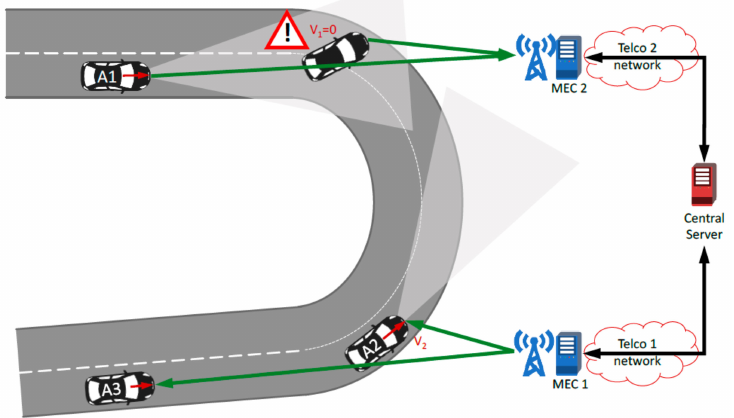
Figure 3. Typical scenario of the anticipated cooperative collision avoidance (ACCA) use case where an abnormal situation cannot be detected by on-board sensors. Cross-border situation where di ff erent mobile network operators (MNOs) have a partial view of the